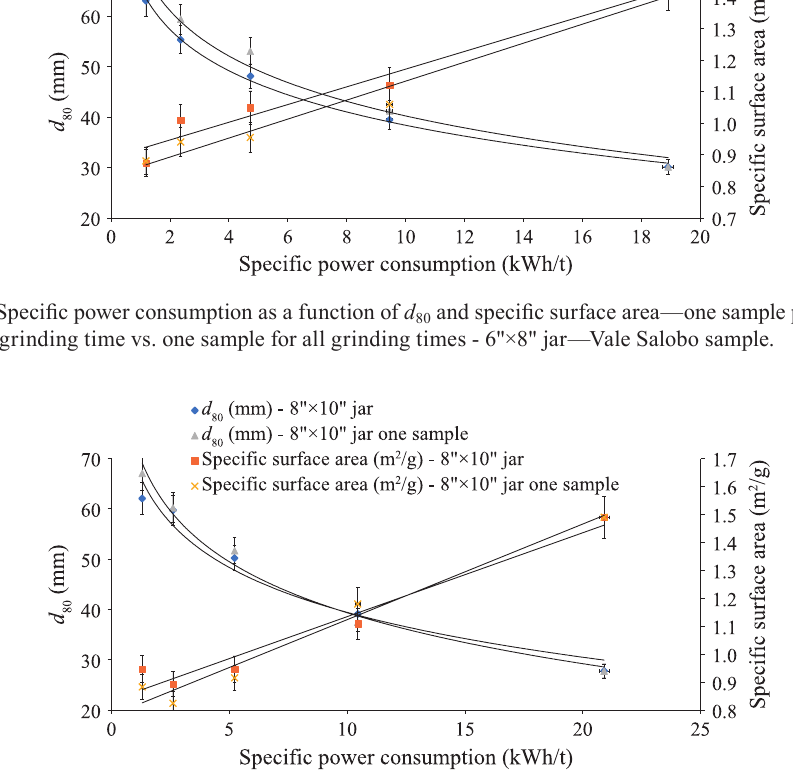
Table 4 Jar test results in both mills for different selected specific energies (10 and 20 kWh/t). Sample Jar 10 kWh/t 20 kWh/t Vale Salobo one sample 6"×8" Vale Salobo one sample 8"×10"